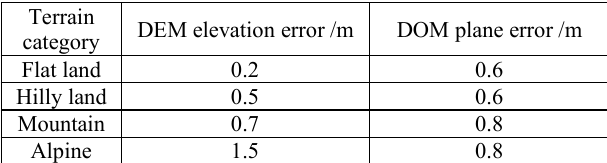
Table 1. Accuracy requirements of 1: 1000 topographic map